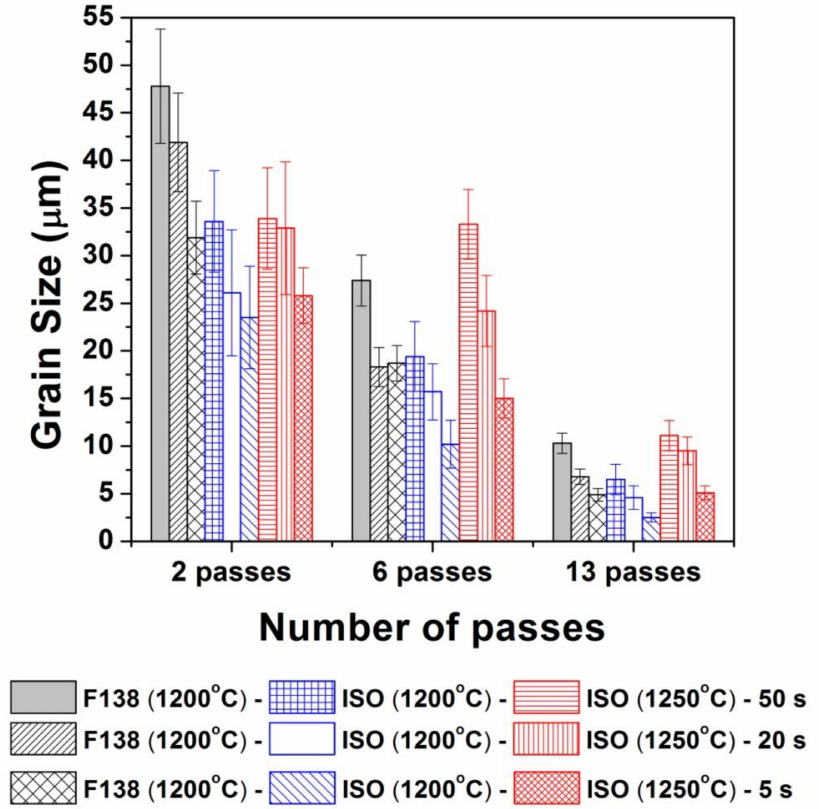
Figure 13. Grain size evolution as a function of the pass number and interpass times. Error bars represent the standard deviation obtained from measurements.